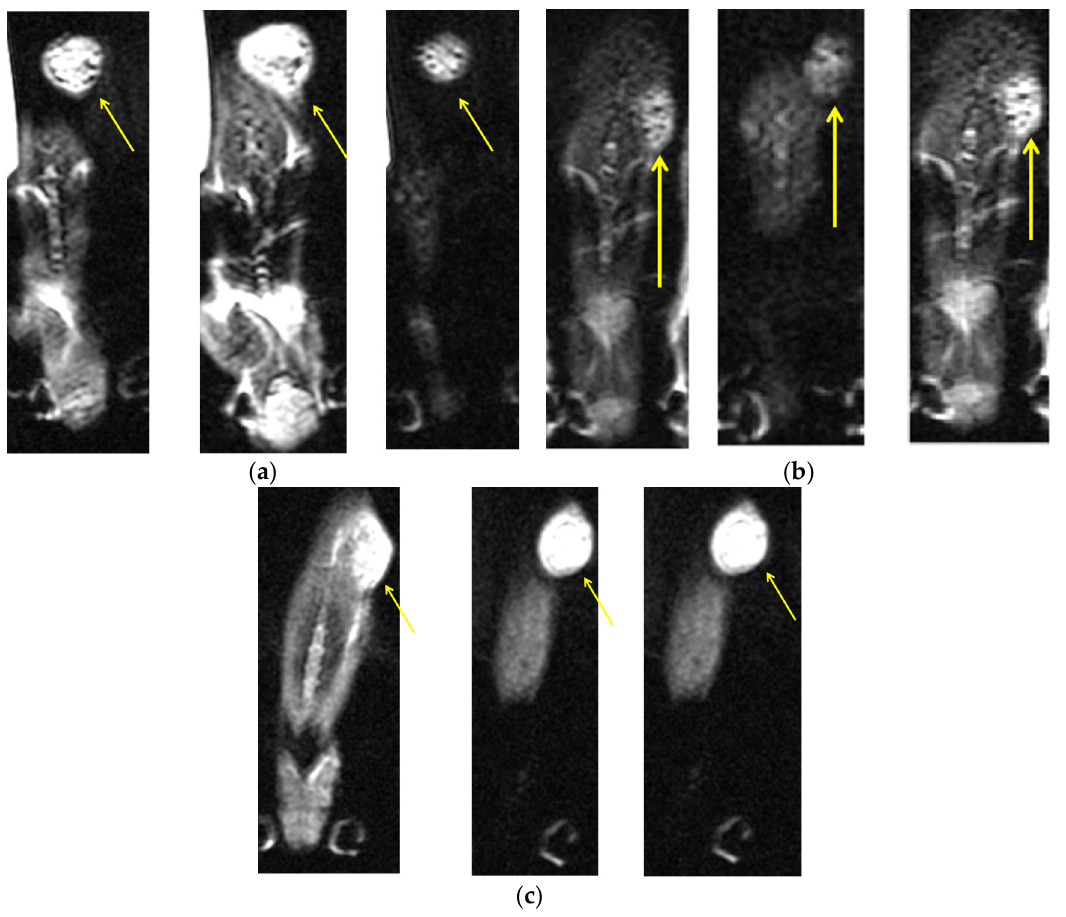
Figure 5. Axial contrast-enhanced axial T2-weighted MRI slices of a head and neck tumor in a representative mouse from each MNP size group, after three cycles of 30 min AMF treatments given on alternating days: ( a ) a mouse with 50 nm coated MNPs; ( b ) a mouse with 100 nm coated MNPs; and ( c ) a mouse with 200 nm coated MNPs. The yellow arrows indicate the tumor sites. Measurements were performed in 3 slices for each mouse (with 8.5 signal averages per position to improve signal-to-noise ratio) resulting in a total data acquisition time of 10 minutes. All MRI slices were 1.0 mm thick with a 0.15 mm in-plane resolution.